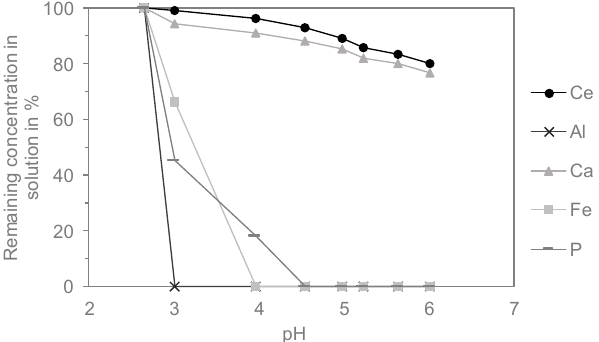
Table 7. Metal ion concentration of a typical leach solution with low impurity content.